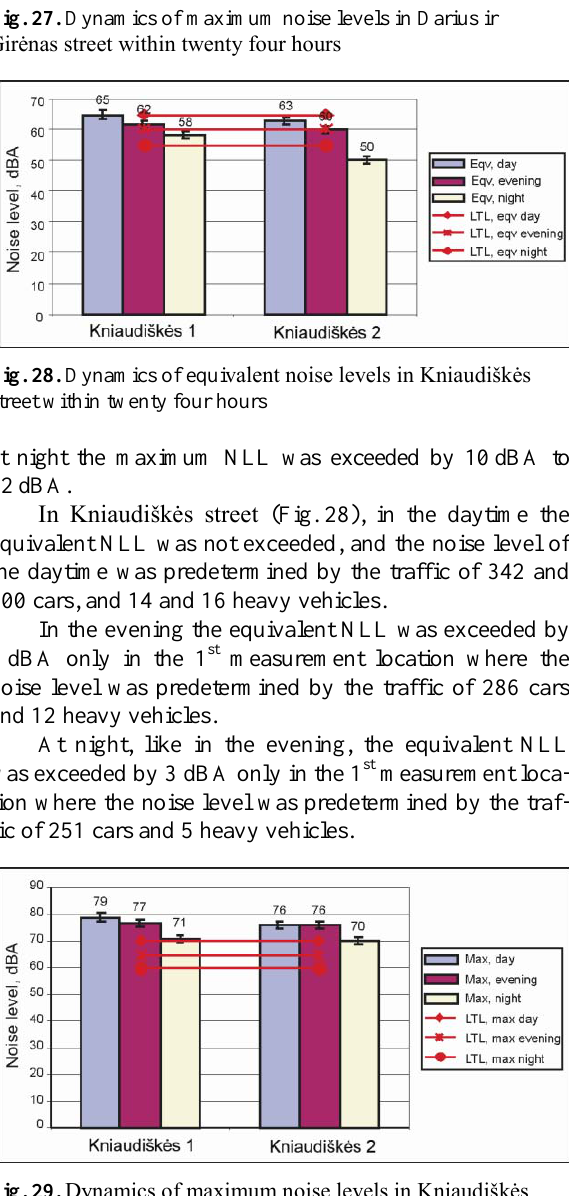
Fig. 29. Dynamics of maximum noise levels in Kniaudiškės street within twenty four hours